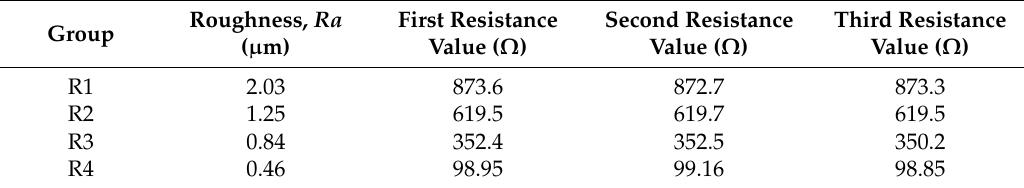
Figure 7. Relationship between roughness and lead connection average resistance. 2.4